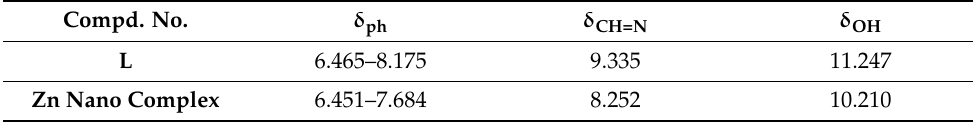
Figure 2. 1 H NMR data for ( a ) free ligand and ( b ) its Zn(II) nano-complex. Table 2. 1 H NMR data for Schiff base ligand and its nano-complex. Compd.